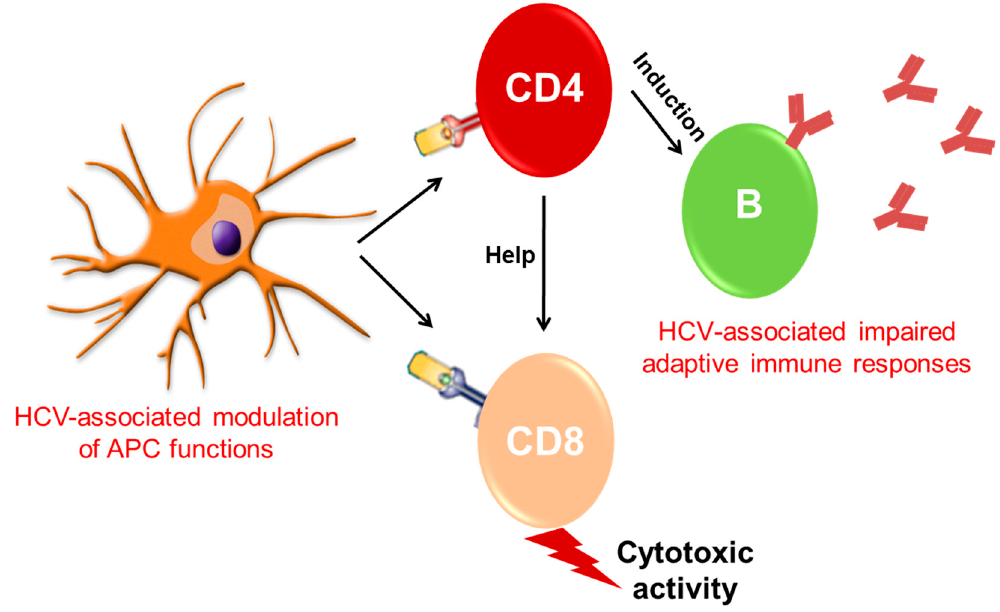
Figure 2. Modulation of APC and CD4 + T/CD8 + T-cell functions by HCV and impairment of adaptive immune